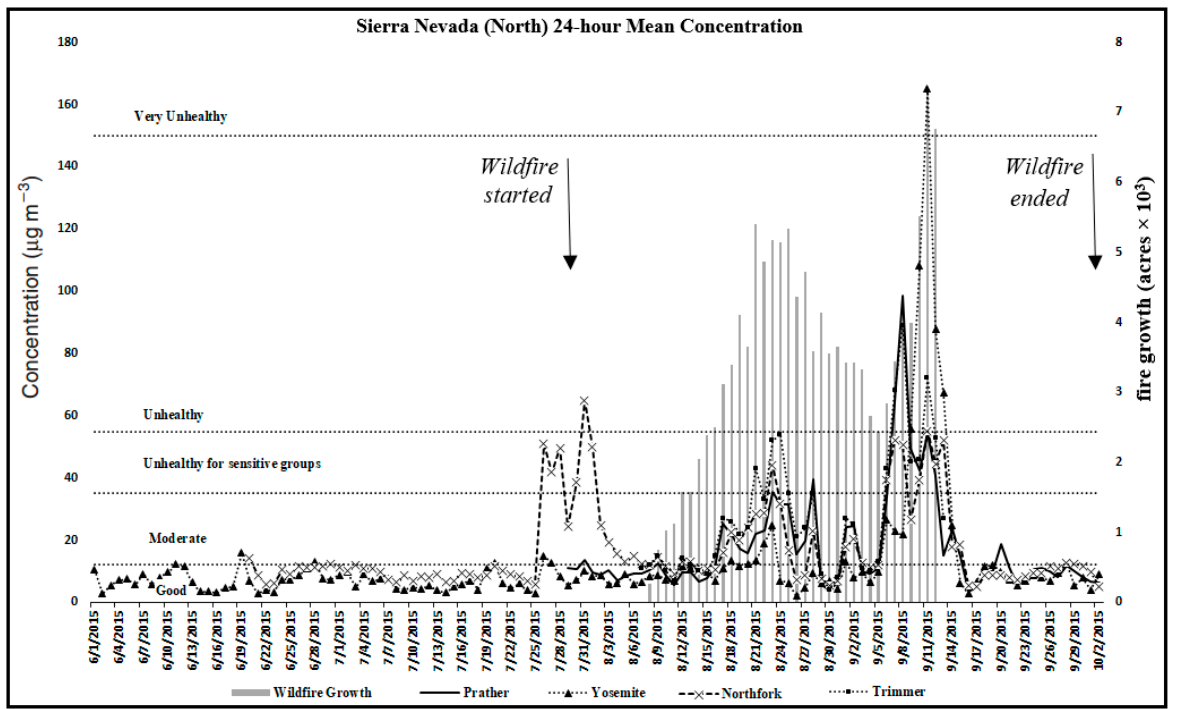
Figure 4. 24-Hour PM 2.5 concentrations with Air Quality Index (AQI) breakpoints for monitoring sites. Note: no daily fire growth data were available at the beginning of the fire.